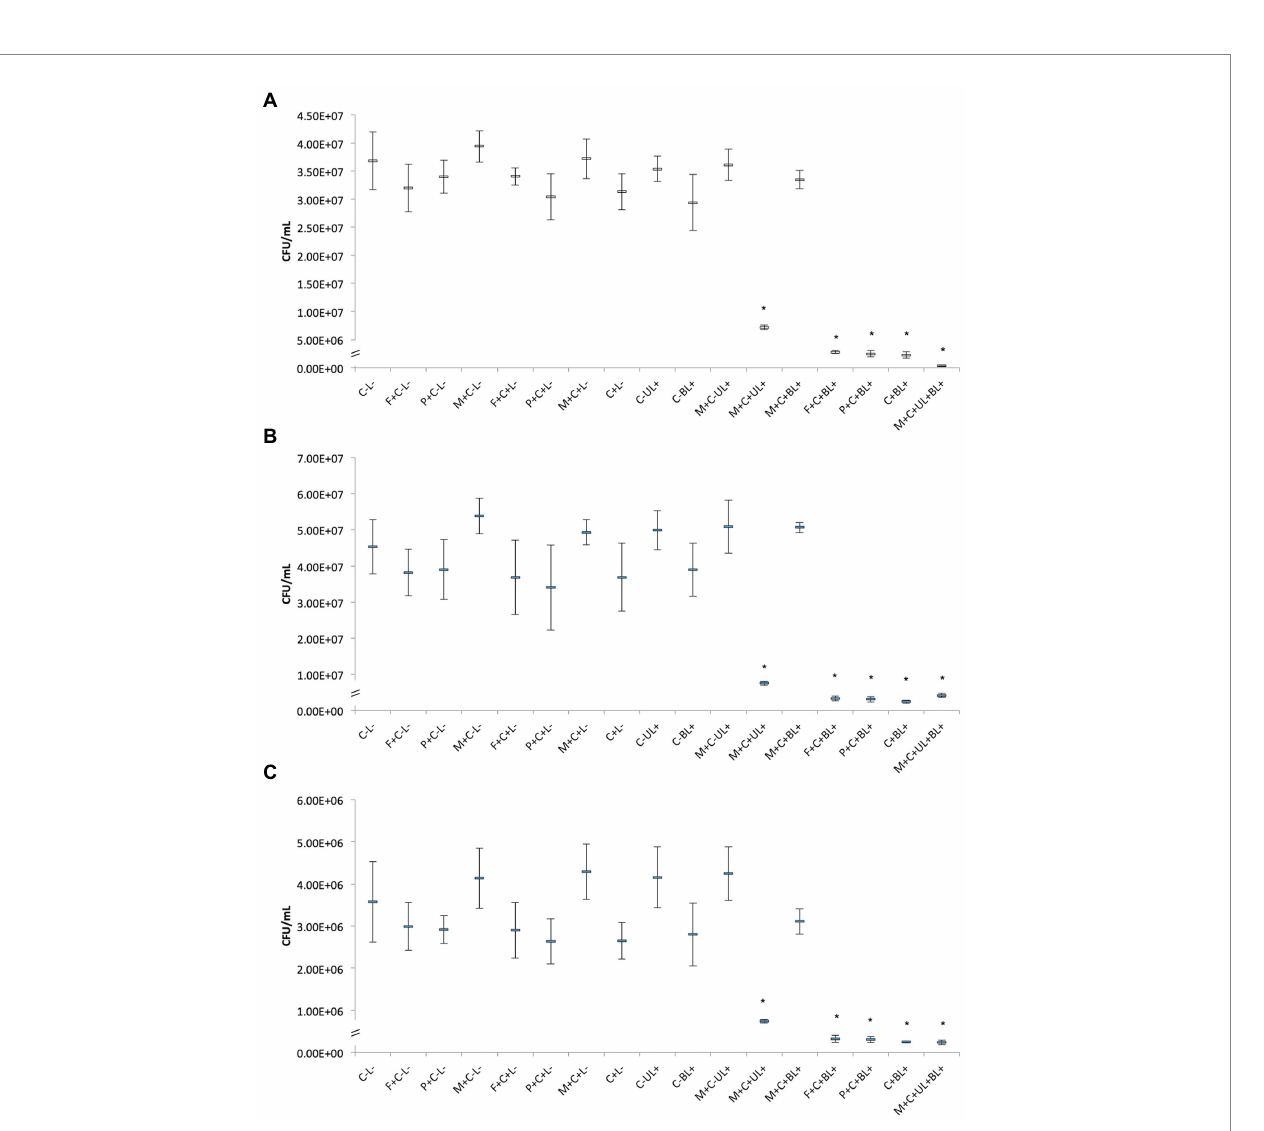
FIGURE 6 Mean CFU/mL values of planktonic cultures of MRSA (A) , P. aeruginosa (B) , and C. albicans (C) obtained in each group of study. Error bars: standard deviation ( n = 12). Asterisks (*) denote significant difference ( p < 0.05) compared with the control (C-L-). The data was analyzed by ANOVA/Welch and Games-Howell post-hoc tests. Groups are described in the Supplementary Chart S1 of Supplementary